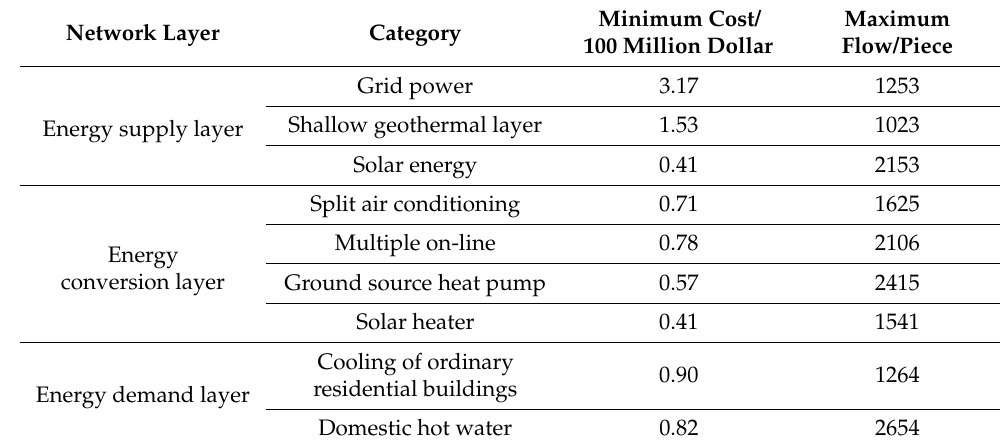
Table 1. Minimum cost and maximum flow of energy model for ordinary residential buildings in summer.